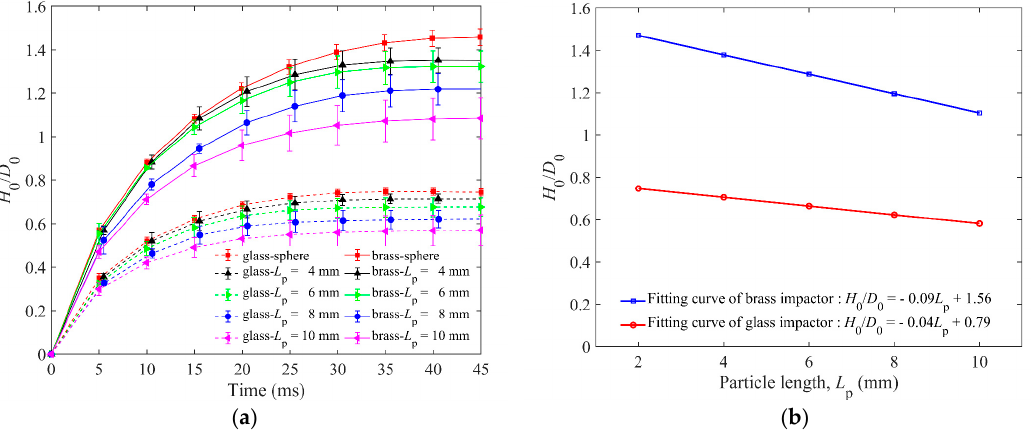
Figure 6. ( a ) H 0 / D 0 versus time for granular bed of spheres and elongated particles of four lengths. ( b ) The fitting curves of the H 0 / D 0 and particle length L p for glass and brass impactors. H 0 and D 0 represent the penetration depth and diameter of the impactor, respectively.